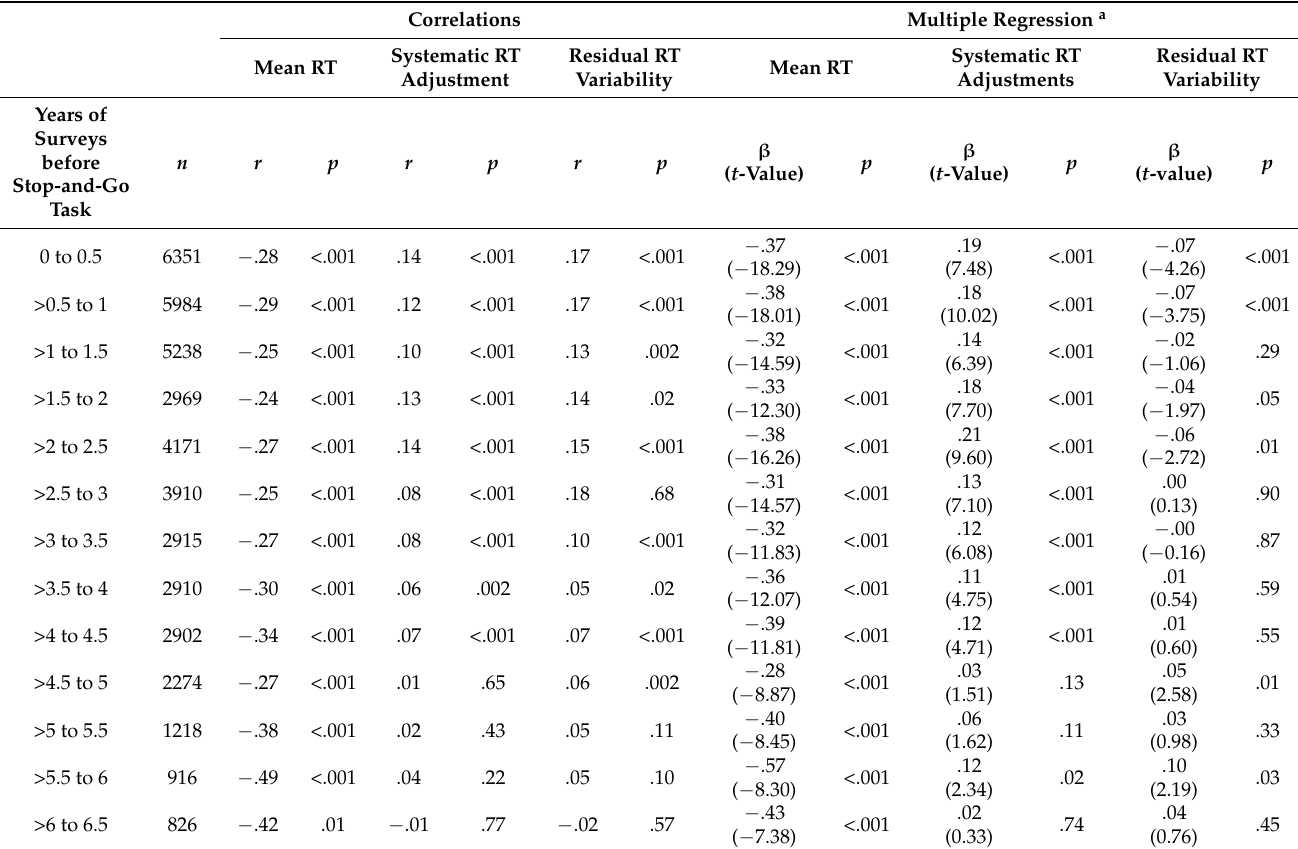
Table 8. Results for response time components as predictors of stop-and-go switch task scores by time lag between surveys and cognitive